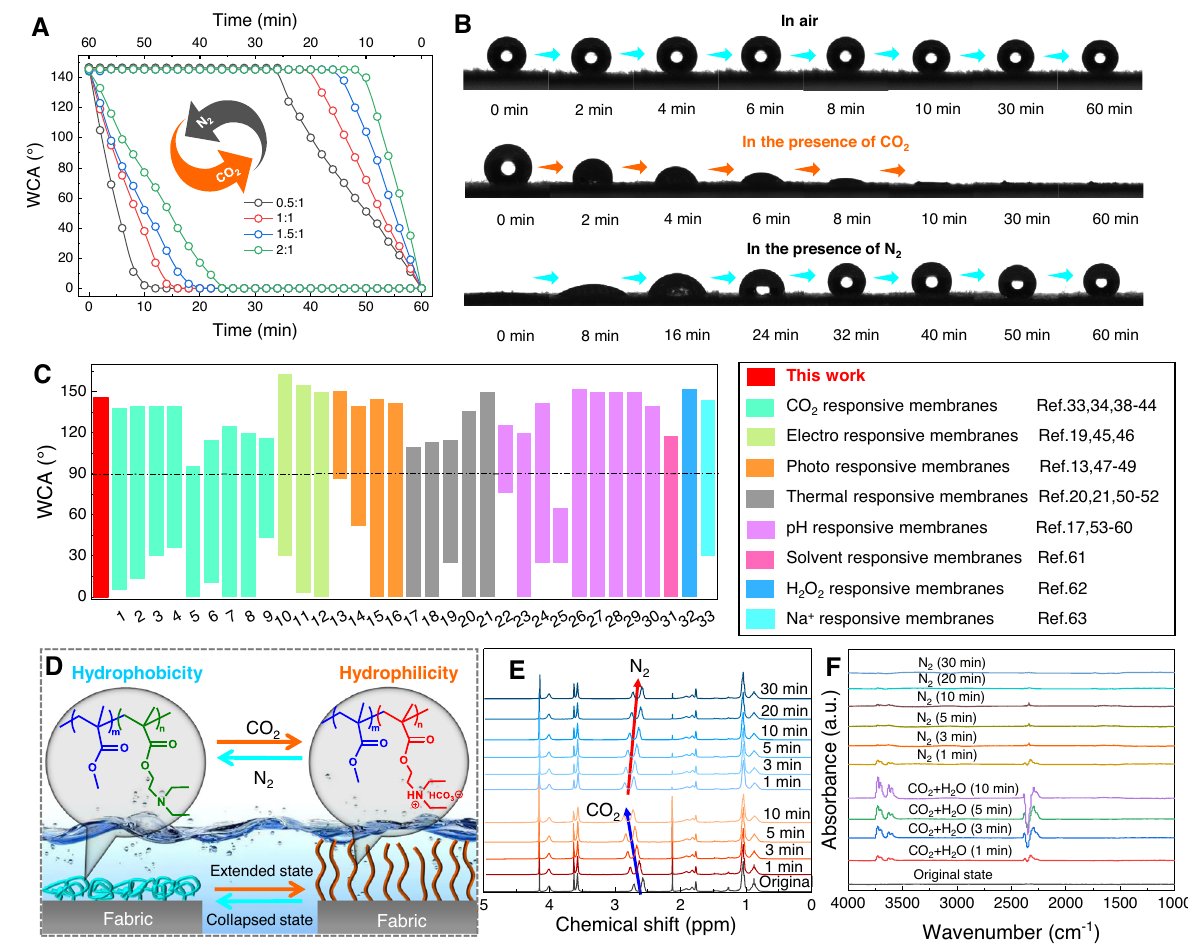
Fig. 2 | Structure characterization and gas-switchable wettability of PPFM. A Time-dependent change in WCA for PPFM-0.5 with gap width of 150 μ m under CO 2 /N 2 treatment. The CO 2 and N 2 were purged at 25°C. The gas fl ow rate was 20mLmin − 1 . B Dynamic optical images of the wettability of a water droplet on PPFM-0.5withgapwidthof150 μ mindifferentstates. C RangeofWCAvaluesofour